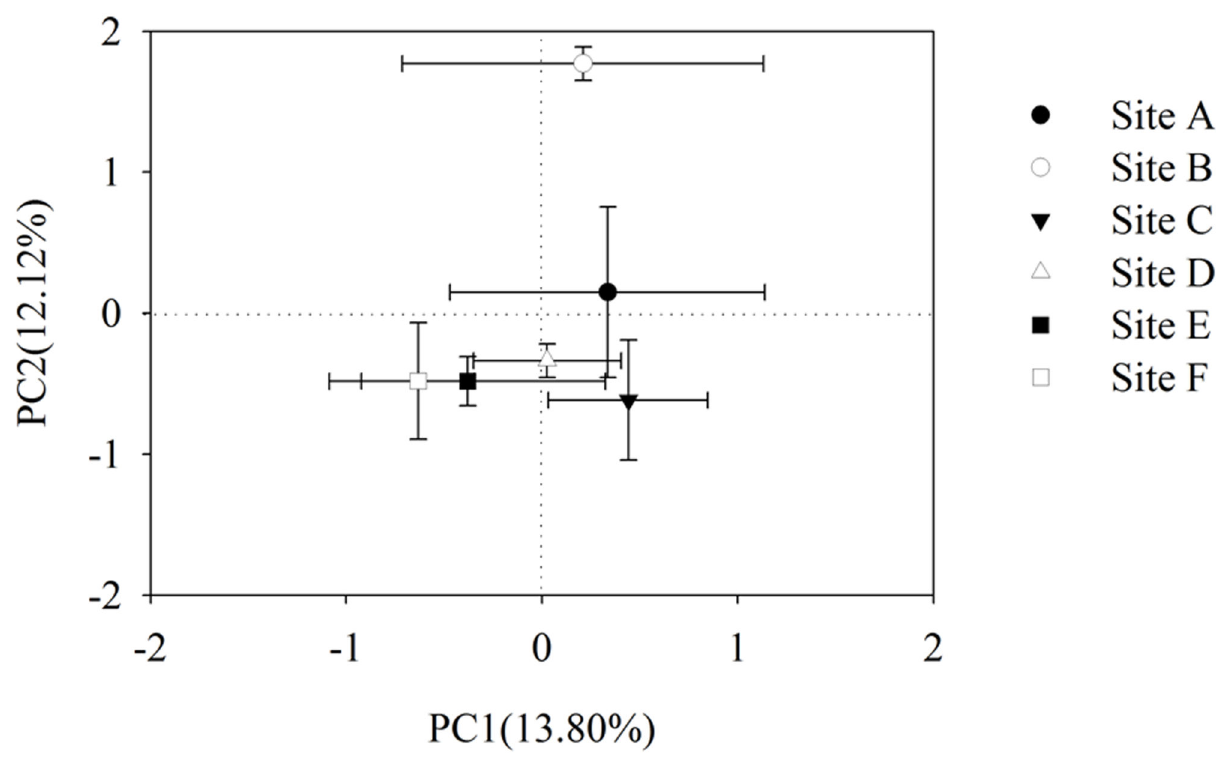
Figure 3. Principle component analyses (PCA) of bacterial functional diversity. Sediments were collected from each six sampling sites (site A, site B, site C, site D, site E, site F) in the Zhou cun drinking water reservoir, eastern China. Data were calculated based on sole carbon substrate utilization pattern using BIOLOG ECO micro plates after incubation of 144 h. Numbers in brackets represent the percentage of variation explained by each factor, PC1 explains 13.80% of the variance of the data and PC2 explains 12.12% of the variance in the data, respectively. Bars represent plus one standard error (S.E) ( n